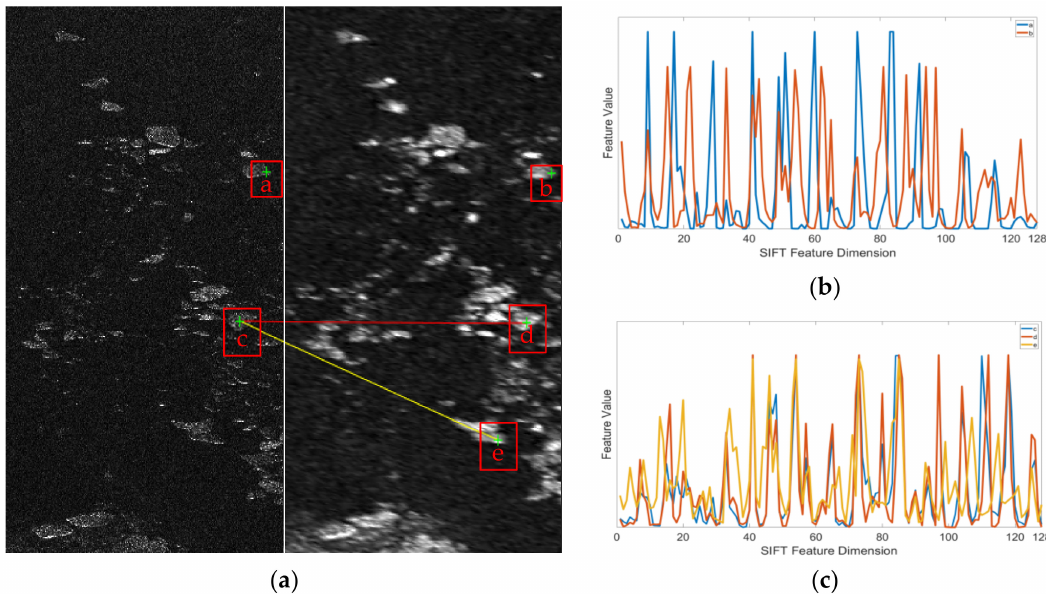
Figure 2. Example of heterogeneous image-pairs. ( a ) An example of a match result. The two images are Radarsat-2 data from the Antarctic region. The right scene is a 100-m resolution image and the left scene is an 8-m resolution image. The time interval between the two scenes is 4 h. ( b ) Feature descriptors of point a and point b extracted using the SIFT algorithm. ( c ) Feature descriptors of point c, point d and point e extracted with the SIFT